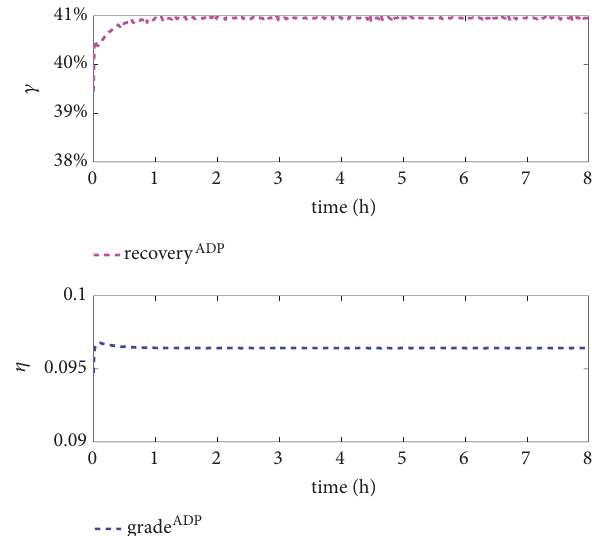
Figure 12: Recovery and grade trajectories in Task 1.